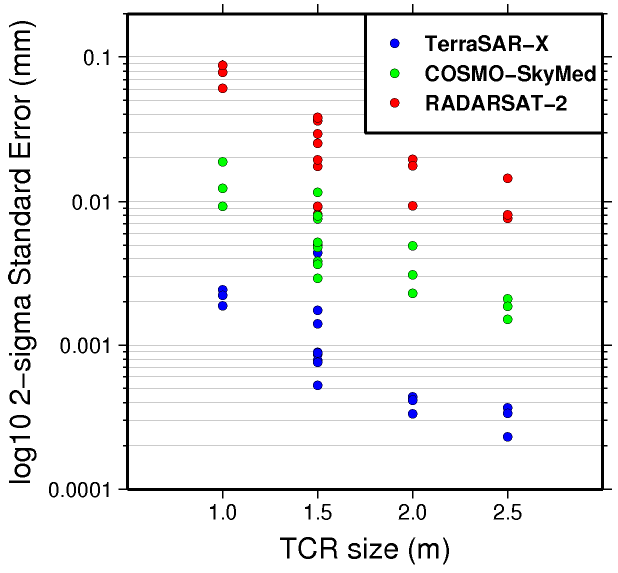
Figure 13. Magnitude of 2-sigma standard errors on the estimated LOS displacement errors (plotted as error bars in Figure 12) grouped according to TCR size.